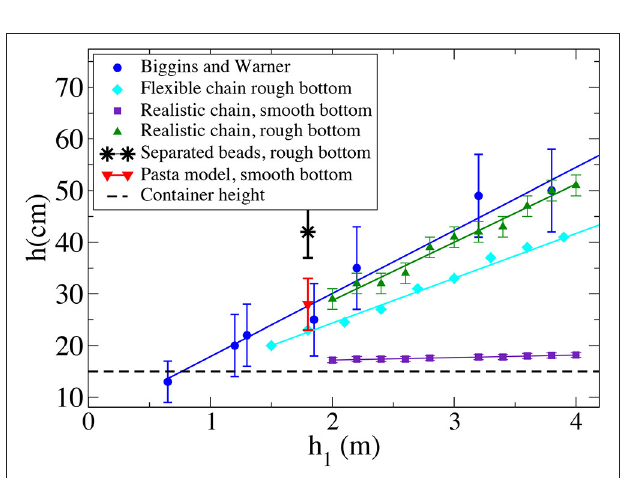
FIGURE 8 | The fountain height as a function of elevation h 1 for the different models.